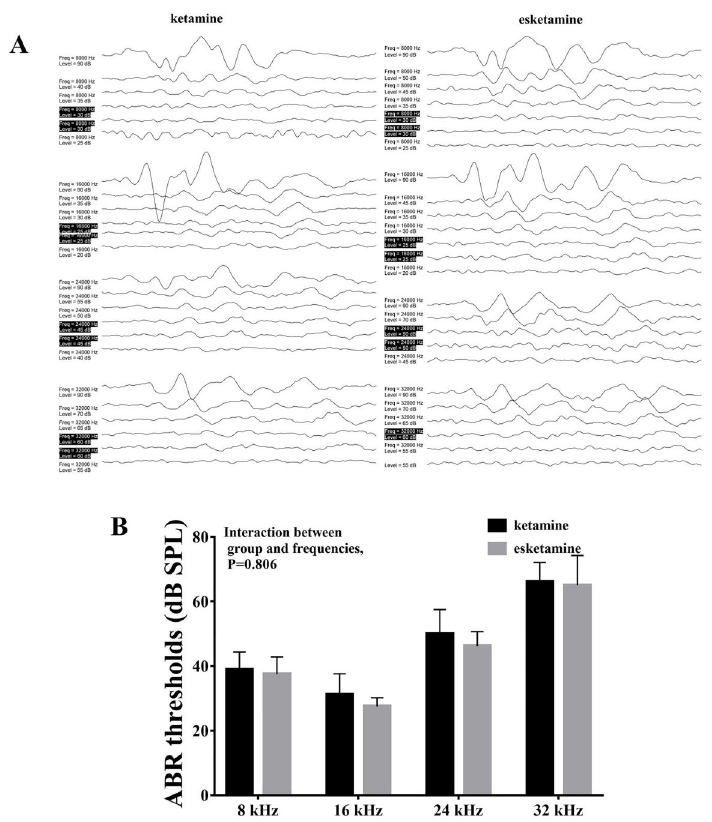
Figure 1. Esketamine did not increase auditory brainstem response (ABR) hearing thresholds in mice. A , ABR measurement at four different frequencies between the ketamine and esketamine groups. B , Hearing thresholds were not increased by esketamine at 8, 16, 24, and 32 kHz frequencies. Data are reported as means ± SE. ANOVA was used to compare the groups. SPL: sound pressure